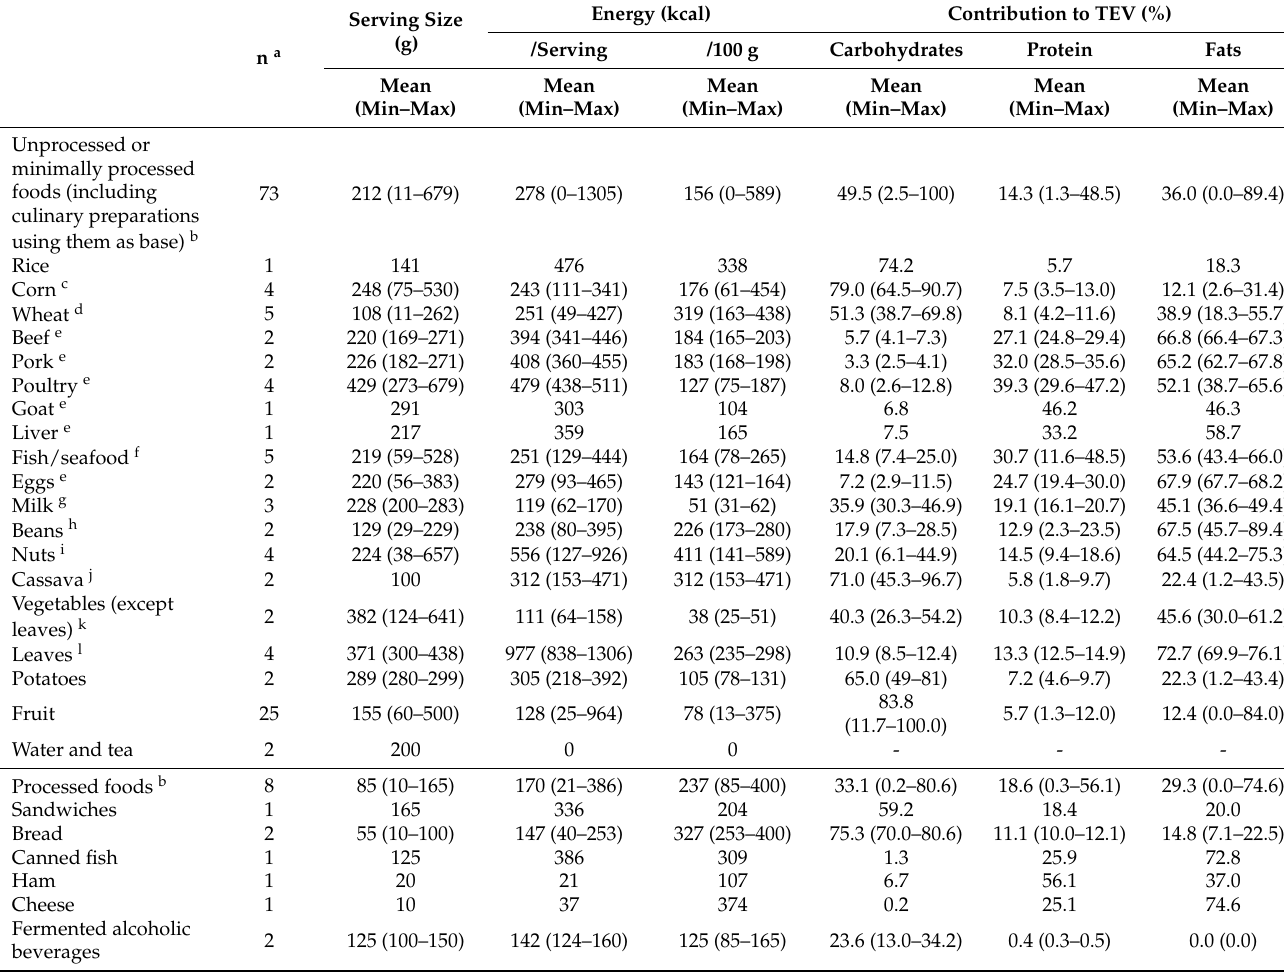
Table 2. Estimated energy content and macronutrient distribution of the ready-to-eat food products available from street food vending sites in KaMpfumu, Maputo, Mozambique, according to degree of processing ( n = 810, available for